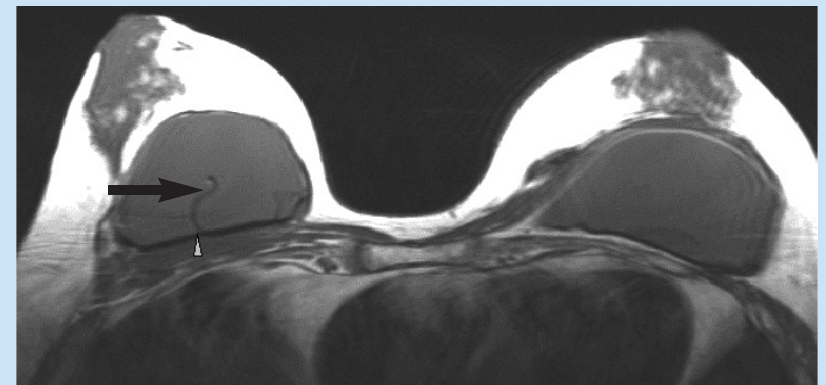
Fig.1 T1-weighted transverse scan of a patient with implanted prostheses demonstrating early rupture of the right prosthesis with a rupture of the posterior wall of the right prosthesis ('wavy' line or 'linguine' sign) (arrow), with fluid escaping posteriorly between the elastomer shell and the breast capsule (arrowhead).